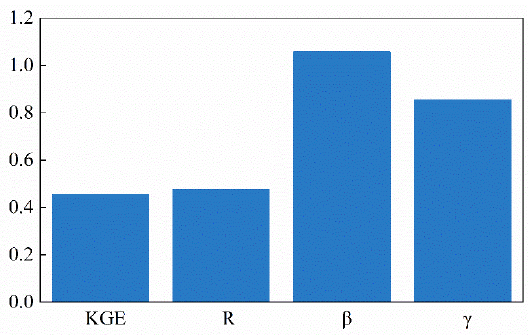
Figure 3. KGE, R, β , γ of the ERA5 basin precipitation data over the verification period (2007, 2008, June–October). KGE = modified Kling–Gupta efficiency coefficient; R = correlation; β = bias errors; γ = variability error.